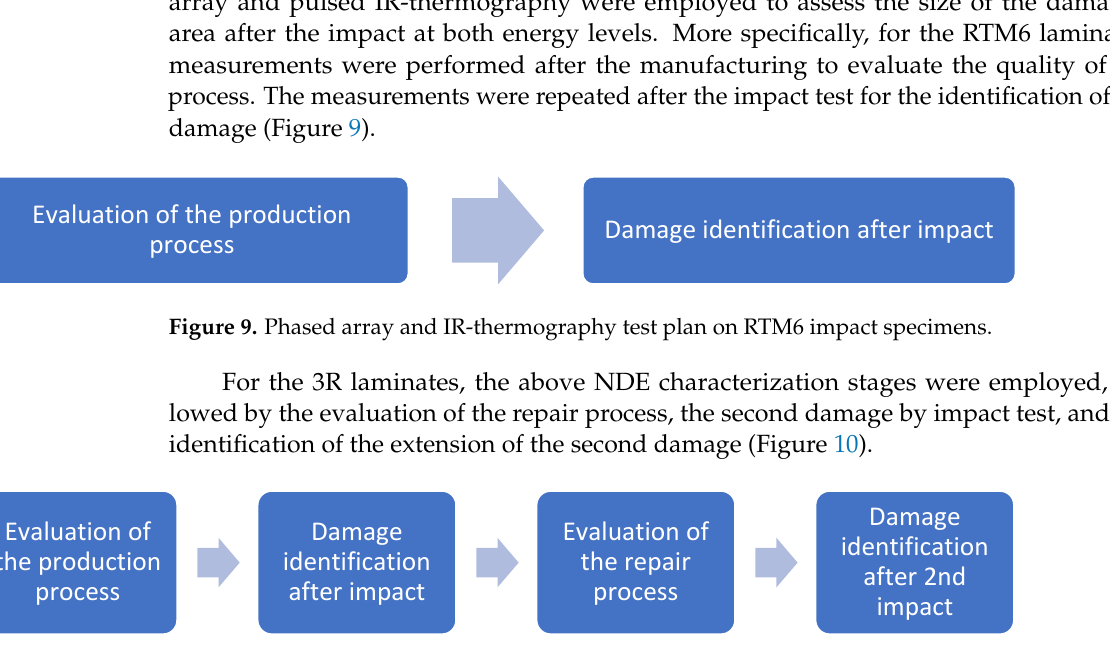
Figure 10. Phased array and IR-thermography test plan on 3R impact specimens.